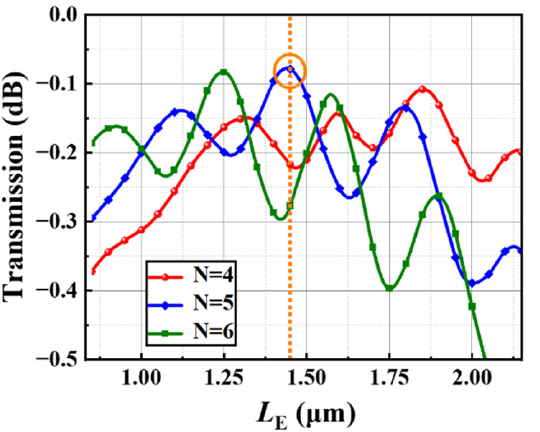
Figure 6. Device transmission of the new designed device as a function of its period number N and relative position L E of the embedded uniform SWG. L S is set as 0.9 μ m.